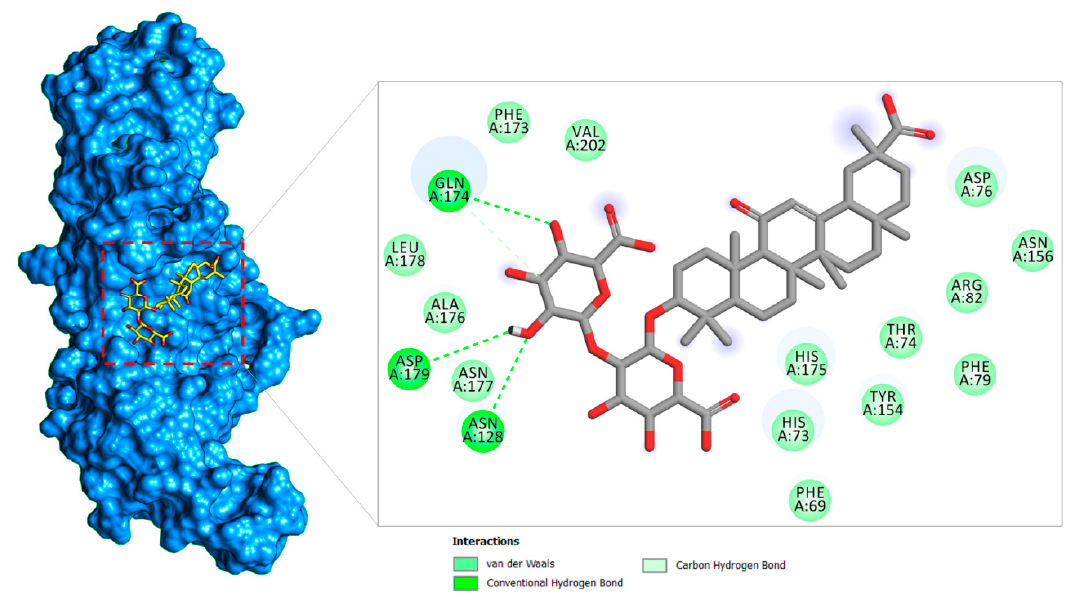
Figure 5. Binding pose of glycyrrhizin (in yellow stick) at the junction binding pocket of PLpro (in blue surface). A 2D illustration of the glycyrrhizin chemical interactions at the docked site is also